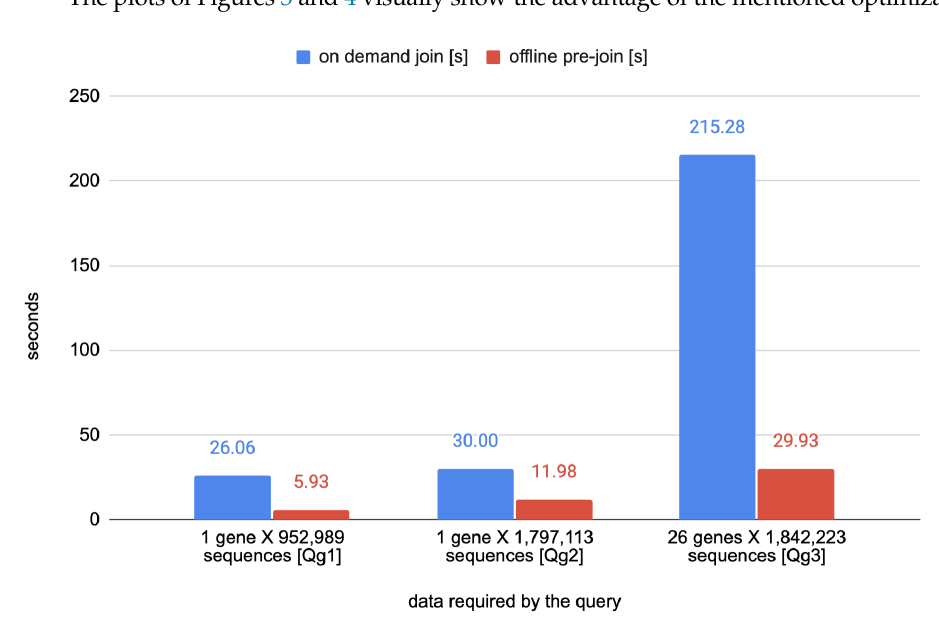
Figure 3. Comparison time required for executing the queries Qg1–3 .